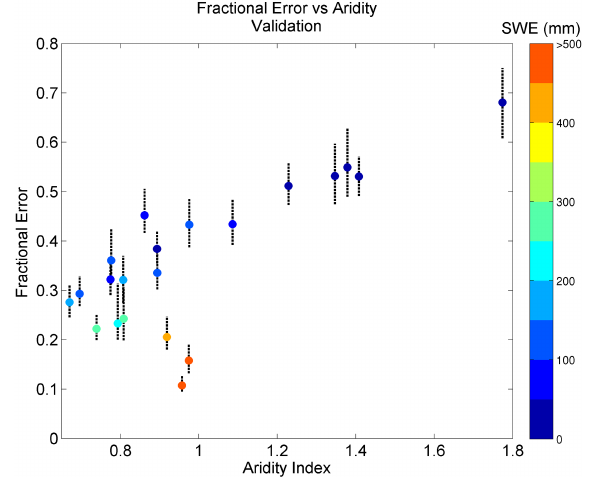
Figure 13. Nash–Sutcliffe efficiency versus the fractional error of the 10 largest error days for the validation period for all basins with basin mean peak snow water equivalent (mm)